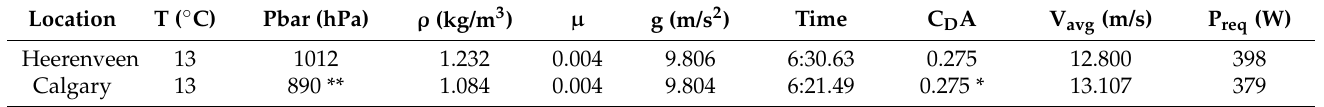
* Without drag-reducing devices, ** including 7 hPa for 65 m height difference airport ice